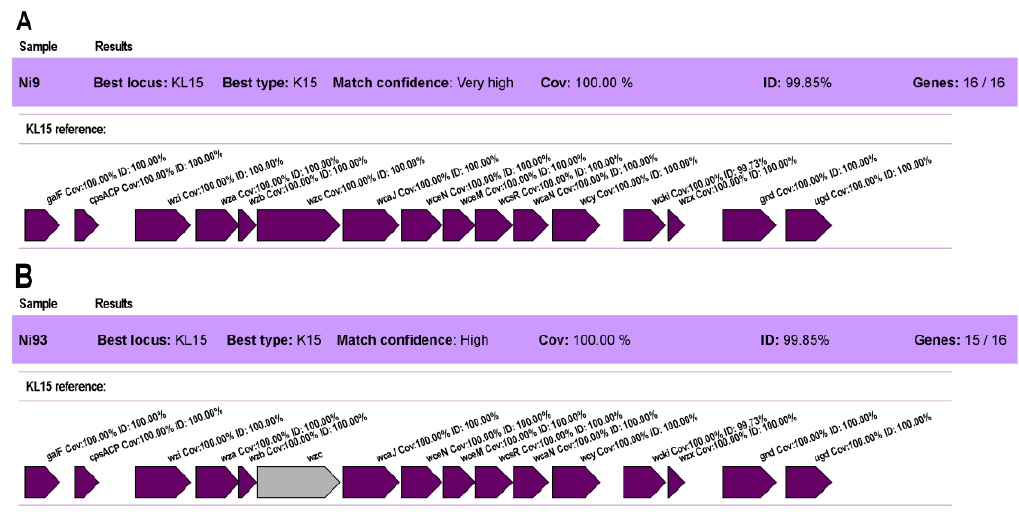
Figure 13. K15 locus analysis with Kaptive software. ( A ) K. pneumoniae Ni9; ( B ) K. pneumoniae Ni93.